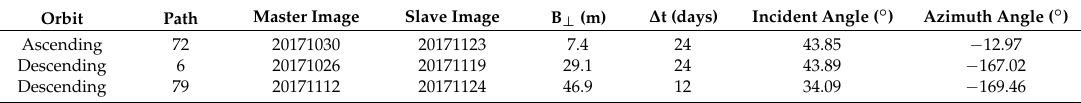
Table 2. Detailed parameters of selected co-seismic interference